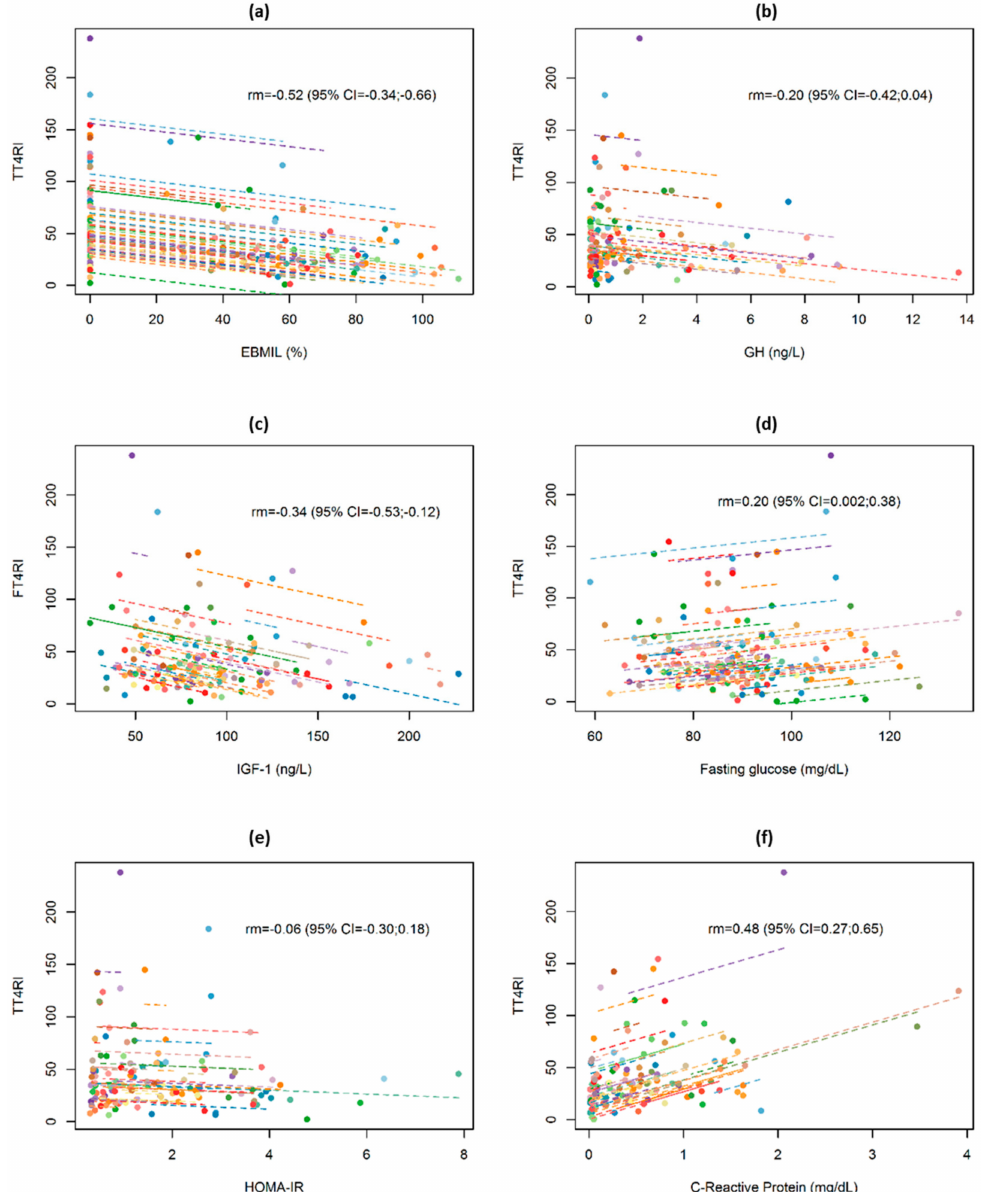
Figure 4. Repeated measures correlation for the overall relationship between changes in thyrotroph T4 resistance index (TT4RI) and ( a ) excessive BMI loss in percentage (EBMIL), ( b ) GH, ( c ) IGF-1, ( d ) Fasting glucose, ( e ) HOMA-IR, and ( f ) C-reactive protein. Obese subjects ( n = 106) are represented by dots that correspond to basal and postoperative TT4RI values and the respective anthropometric, biochemical, and hormonal data. Each line represents the repeated measures correlation fit for each participant. After adjusting for EBMIL and CRP in a multivariate model, both variables were significantly and independently associated with TSHRI and TT4RI values in the follow-up, with a higher excess weight loss associated with lower thyroid resistance indices, whilst higher C-reactive protein values were associated with higher values in both indices (Table